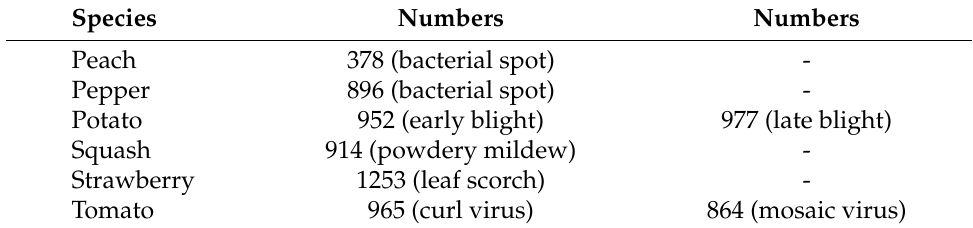
Table 3. Distribution of disease data